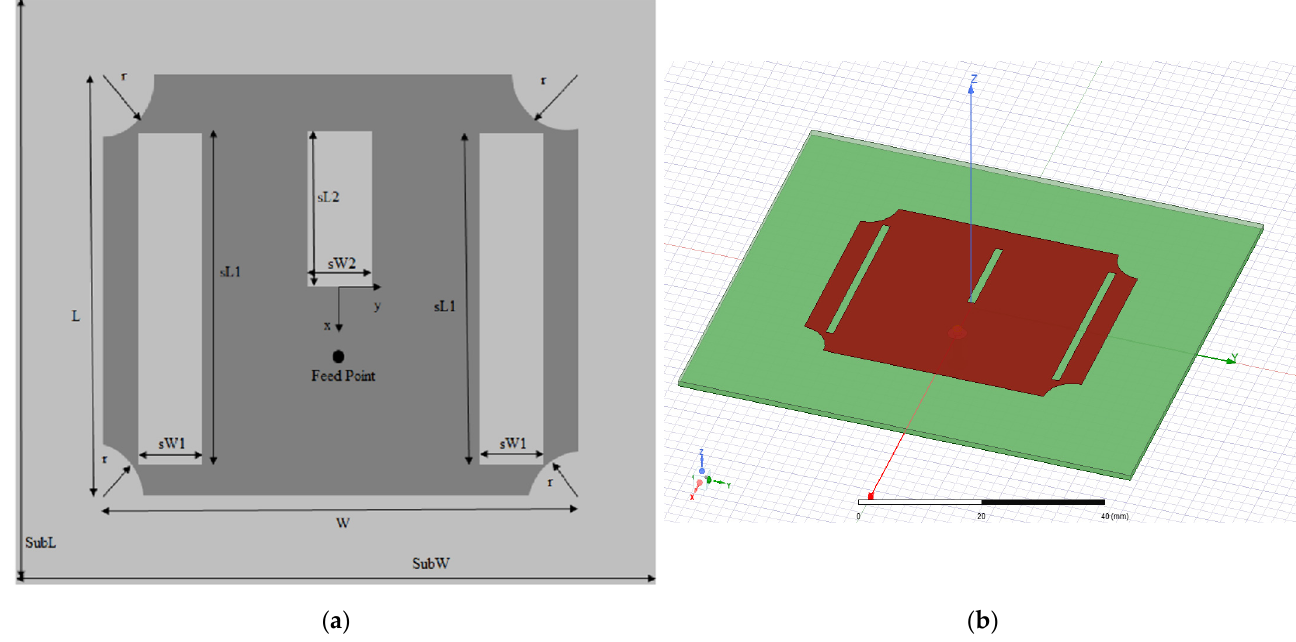
Figure 1. Drawings of the proposed antenna: ( a ) general schematic representation of MPATSAT; ( b ) sketch of MPATSAT in HFSS.